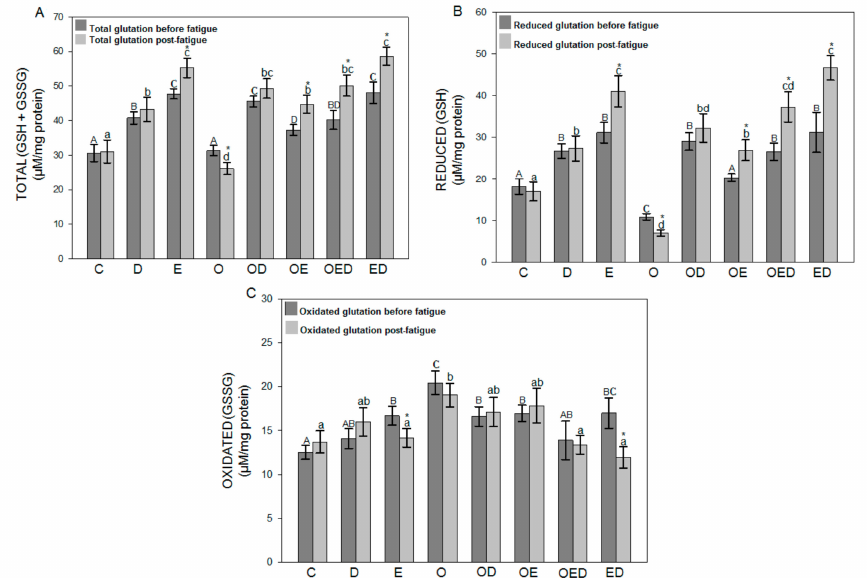
Figure 3. E ff ect of diazoxide and exercise on glutathione redox status in slow skeletal muscle of obese rats. ( A ) Total glutathione soleus muscle, ( B ) reduced soleus glutathione muscle, and ( C )